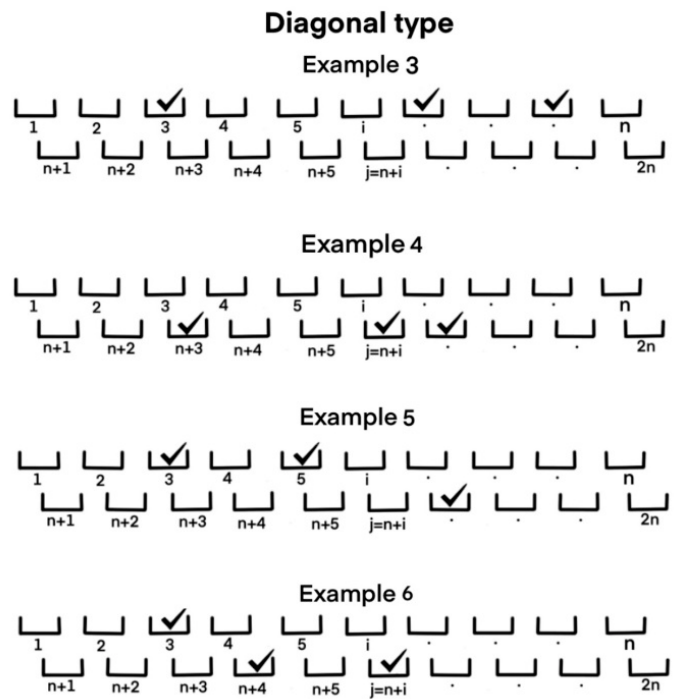
Figure 4. Discharge options for 𝑘 = 3 in double-layered diagonal machines. Table 1. Number of combinations per package for 𝑛 = 16 in standard (single-layered), double- layered upright, and double-layered diagonal machines. Double-Layered Double-Layered k Single Layered Upright Diagonal